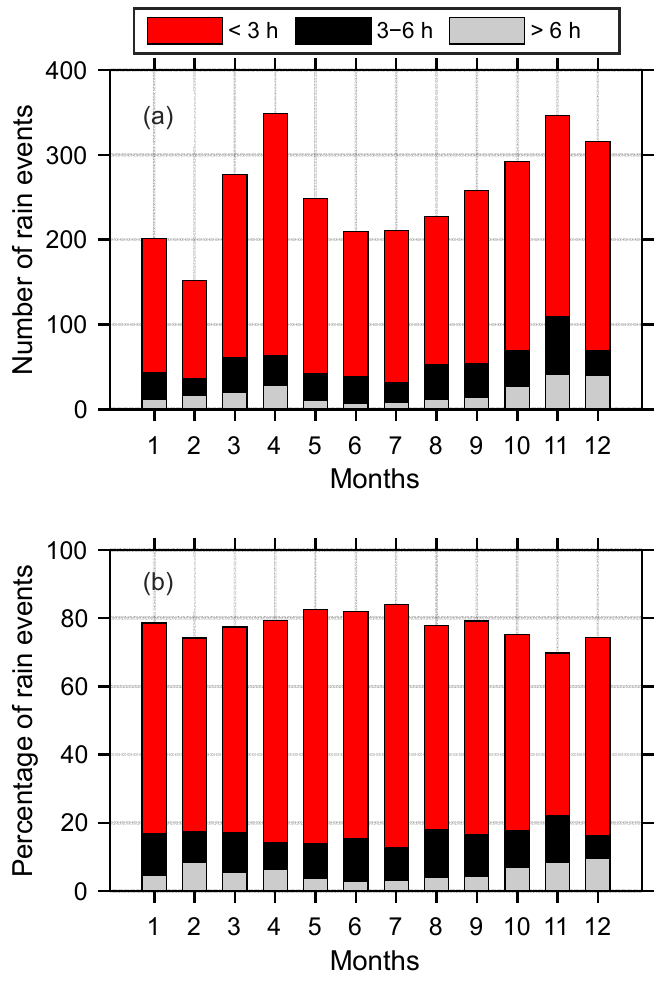
Figure 7. Monthly variations in the number ( a ) and percentage ( b ) of rain events for different rain event durations. The percentages shown in Figure 7b were calculated by dividing the number of events for each duration by the total number of events in that month.